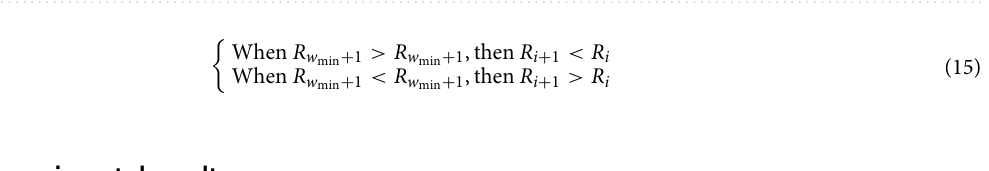
Figure 9. Identification examples of trigger time and amplitude of a same fracture event by six AE